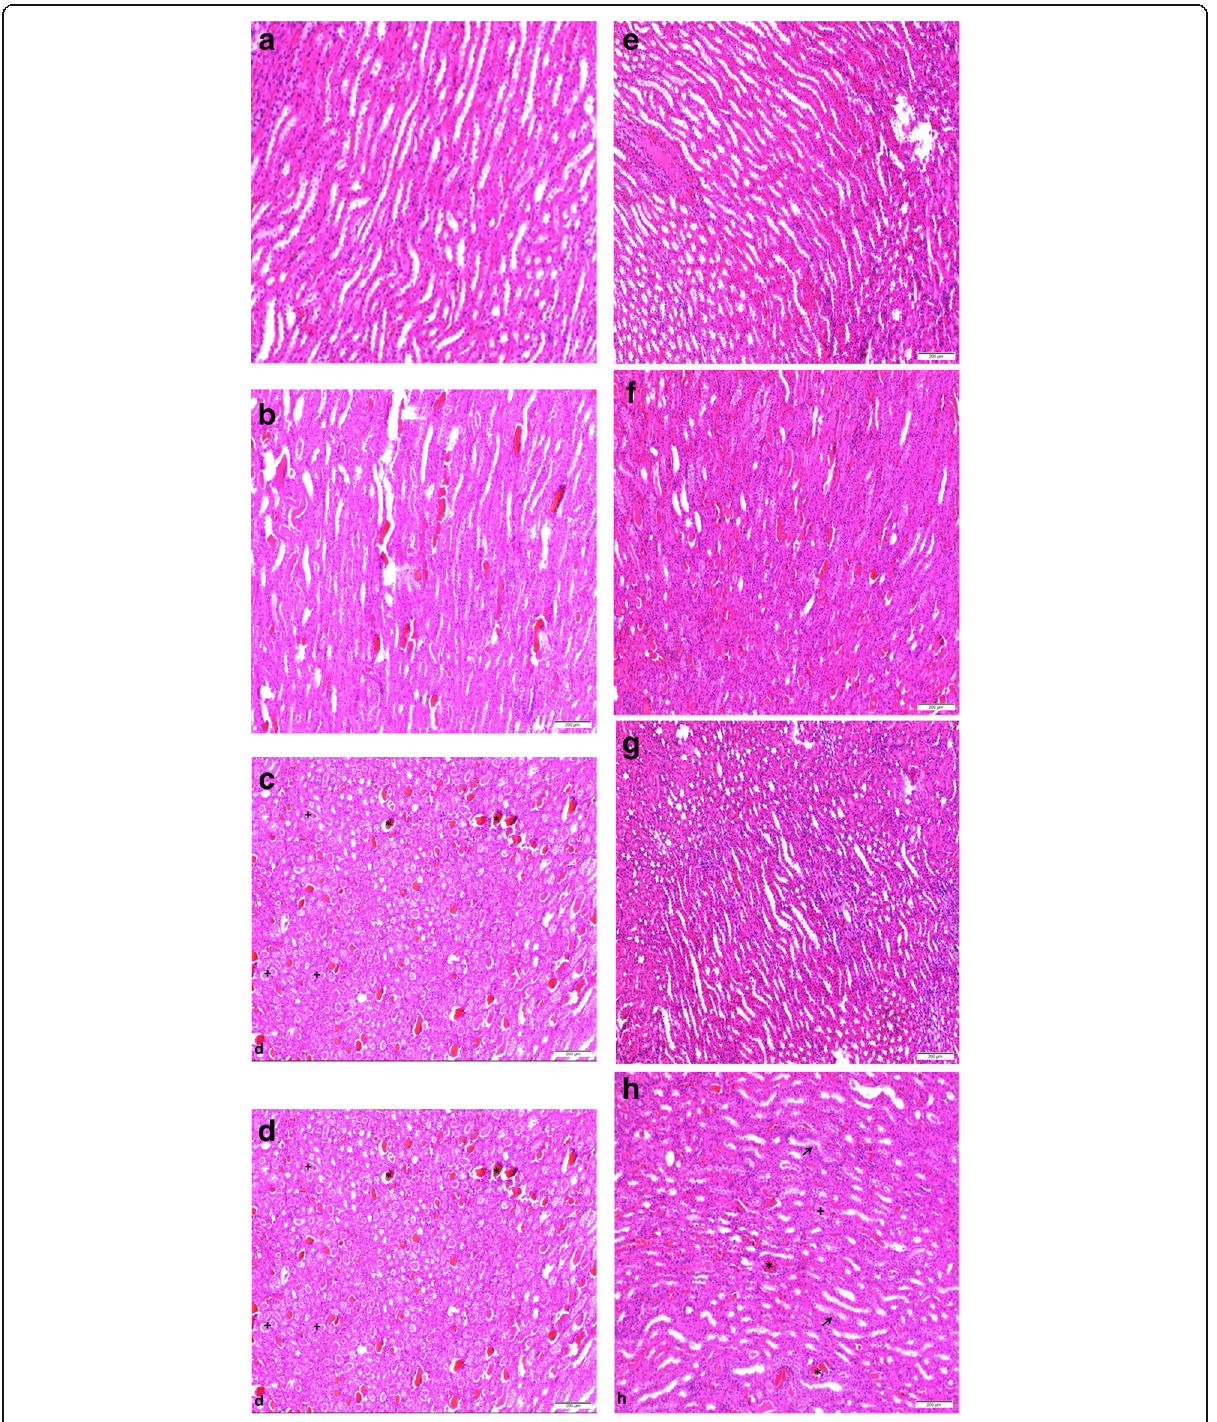
Fig. 5 Haematoxylin and eosin result in rats ’ kidney tissue; magnification 100×. Groups and histopathology specimens are seen. a Normal structure of kidney in the control group. b Hyaline and haemorrhagic casts are seen drastically and moderately; tubular necrosis also is present. c Only haemorrhagic casts are seen moderately; hyaline casts and tubular necrosis are observed slightly. d Hyaline ( + ) and haemorrhagic casts (*) are seen drastically; moderate tubular necrosis is present. e Only haemorrhagic casts are seen slightly. f Both hyaline casts and tubular necrosis are seen moderately; haemorrhagic casts are also present drastically. g Only haemorrhagic casts are seen slightly. h Hyaline ( + ) and haemorrhagic casts (*) are seen as decreased; tubular necrosis (arrow) is seen